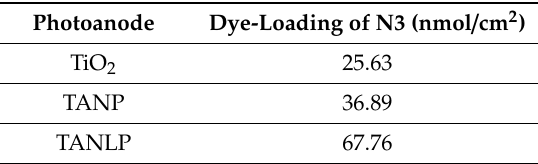
Table 1. Amount of dye-loading of N3 on photoanode.